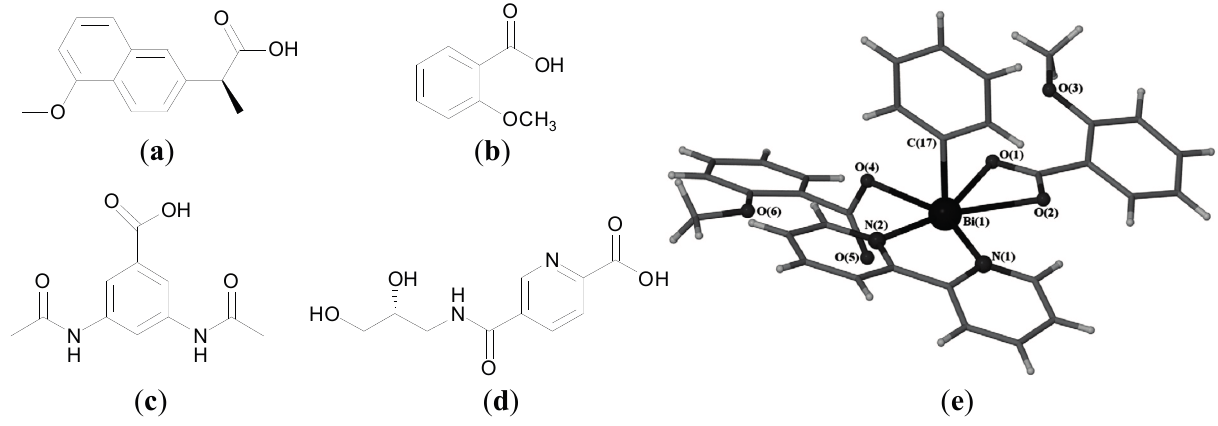
Figure 13. Structures of ( a ) naproxen, ( b ) o -methoxybenzoic acid, ( c ) 3,5-diacetamido-benzoic acid and ( d ) 5-[( R / S )-2,3-dihydroxypropylcarbamoyl]-2-pyridinecarboxylic acid; ( e ) Molecular structure of [PhBi(o-MeOC 6 H 4 CO 2 ) 2 (bipy)]. Reprinted with permission from [110]. Copyright (2011)